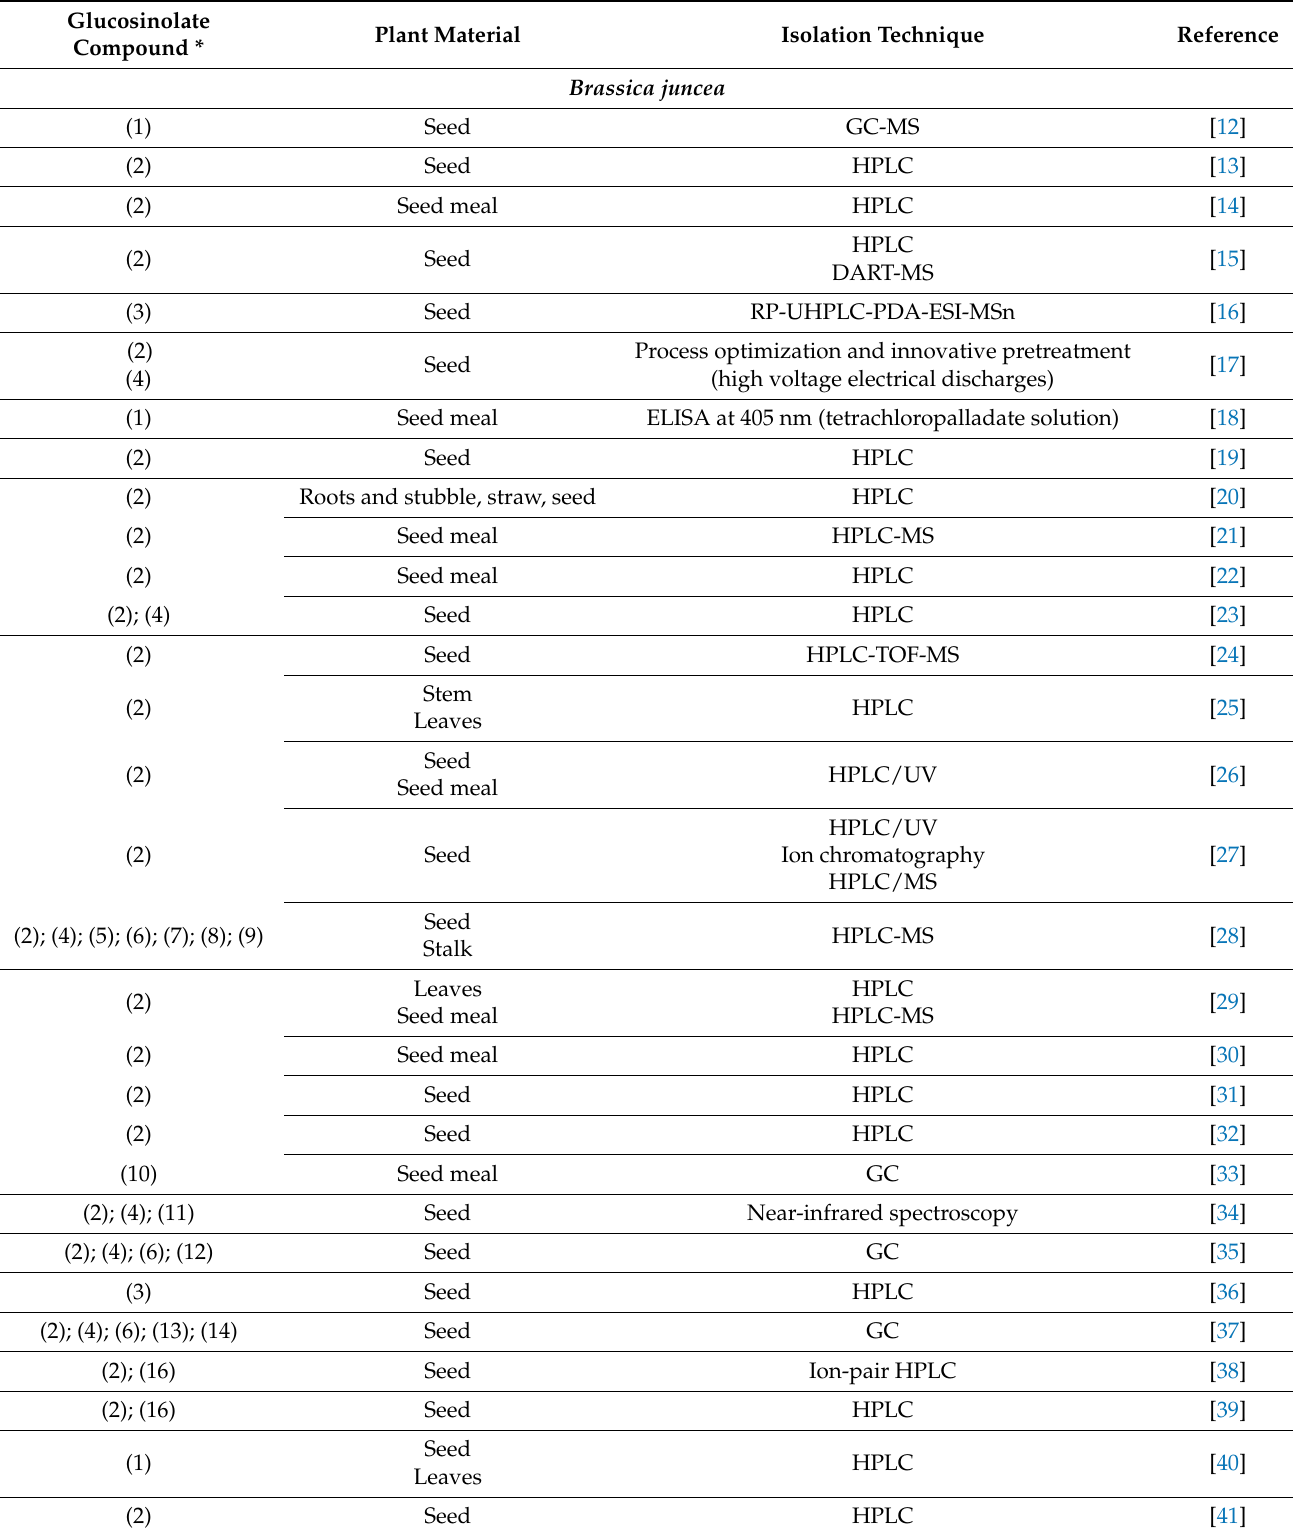
Table 1. List of major glucosinolates and omega-3 fatty acids in each mustard seed species and its separation